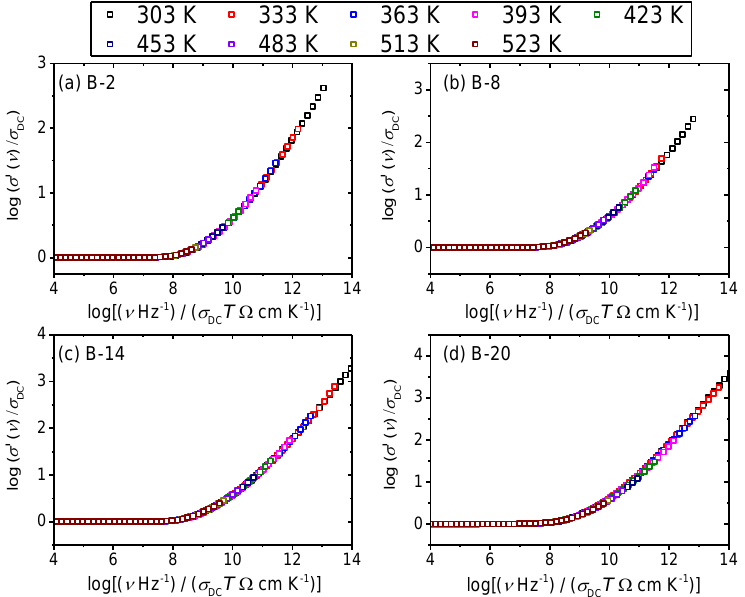
Figure 5. Conductivity spectra scaled according to the Summerfield scaling procedure for ( a ) B-2, ( b ) B-8, ( c ) B-14 and ( d ) B-20 glasses.